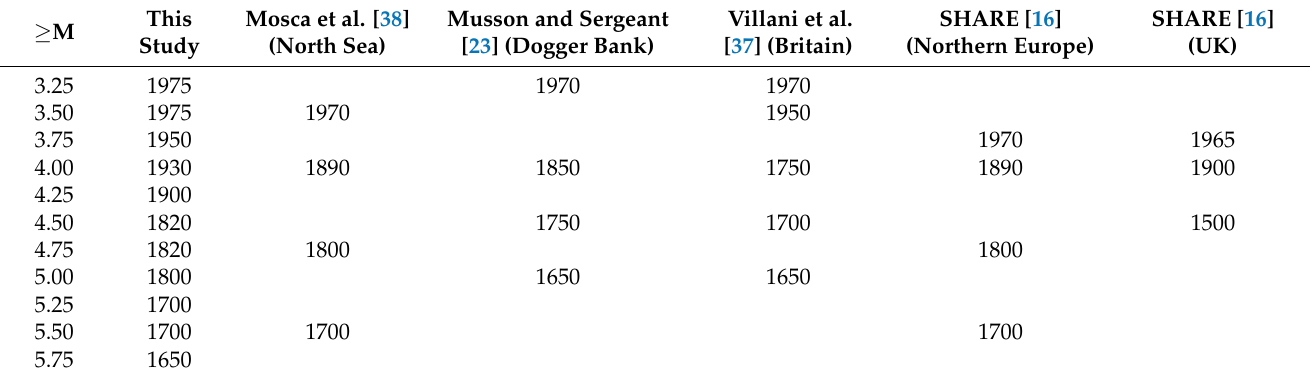
Table 4. Completeness years for this study compared with several other studies for nearby regions.